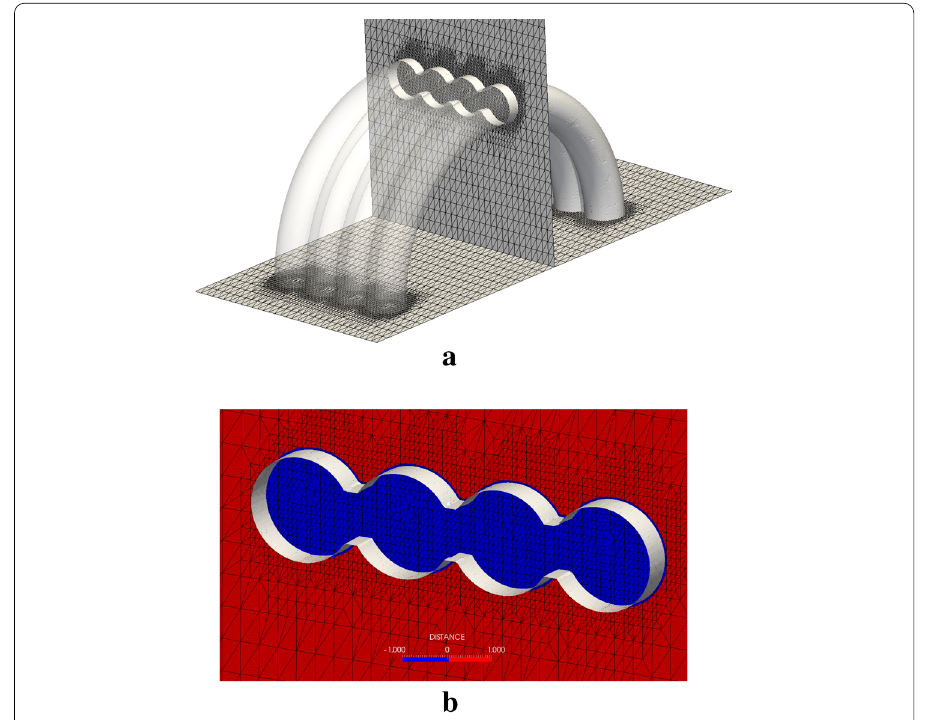
Fig. 37 Sign of nodal distances at a cross-section of the hangar (a positive sign indicates a node outside the tubes and a negative sign a node inside). a Position of cross-section. b Sign of nodal distance values